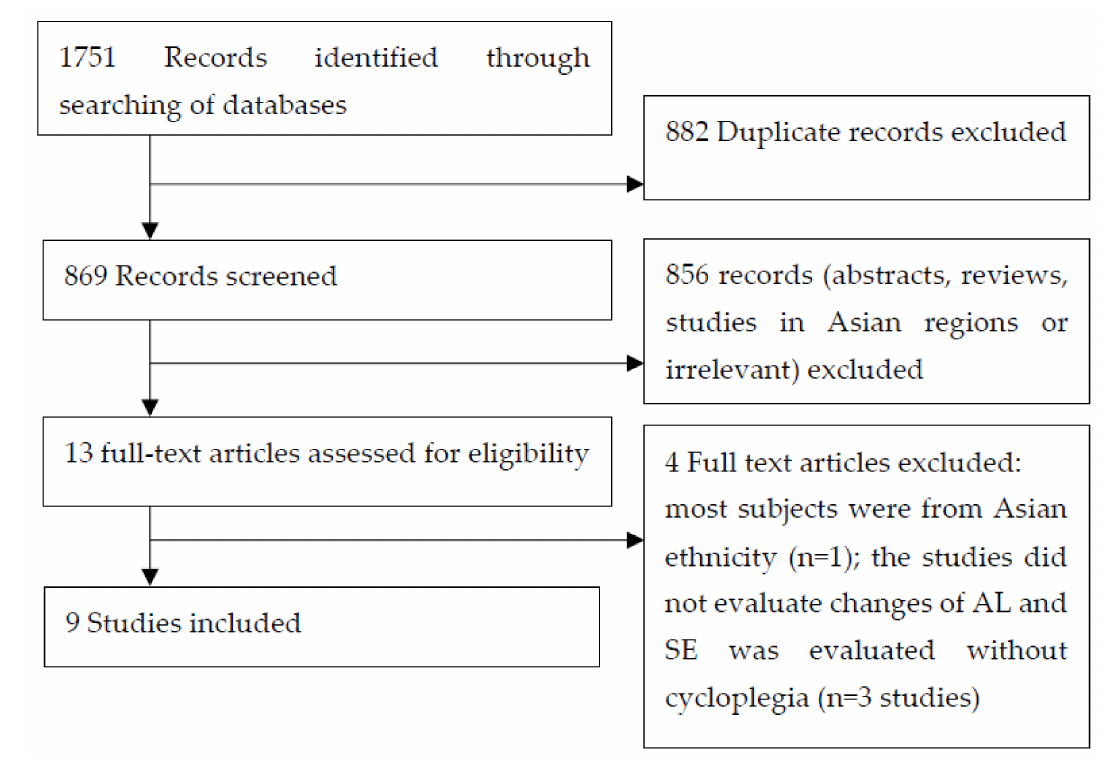
Figure 1. Flowchart of study selection